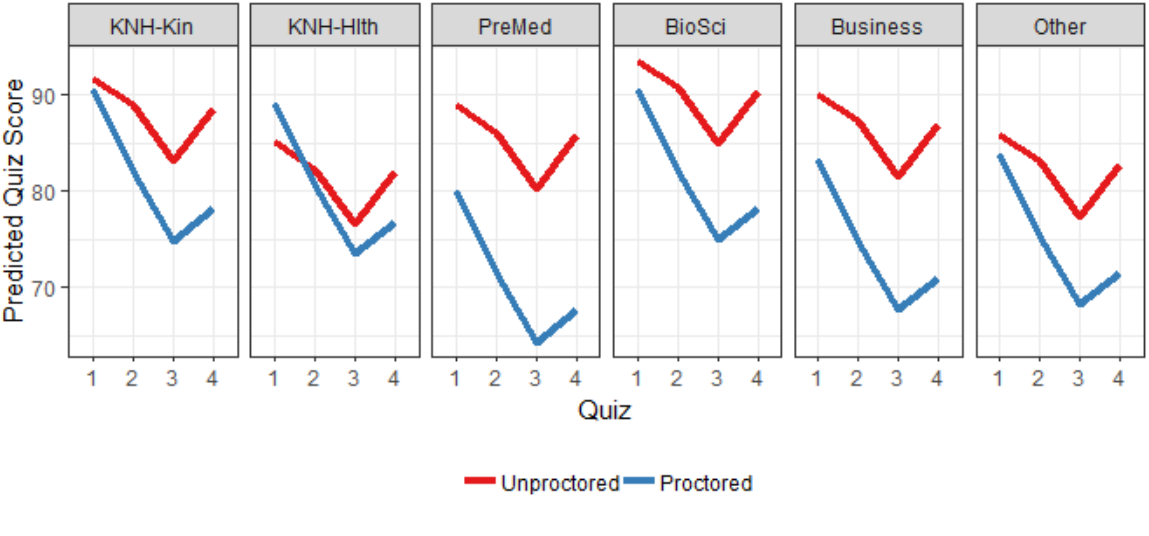
Figure 3 . Plot of predicted quiz scores under each combination of student major, quiz number, and proctoring status based on fixed effects structure from fitted